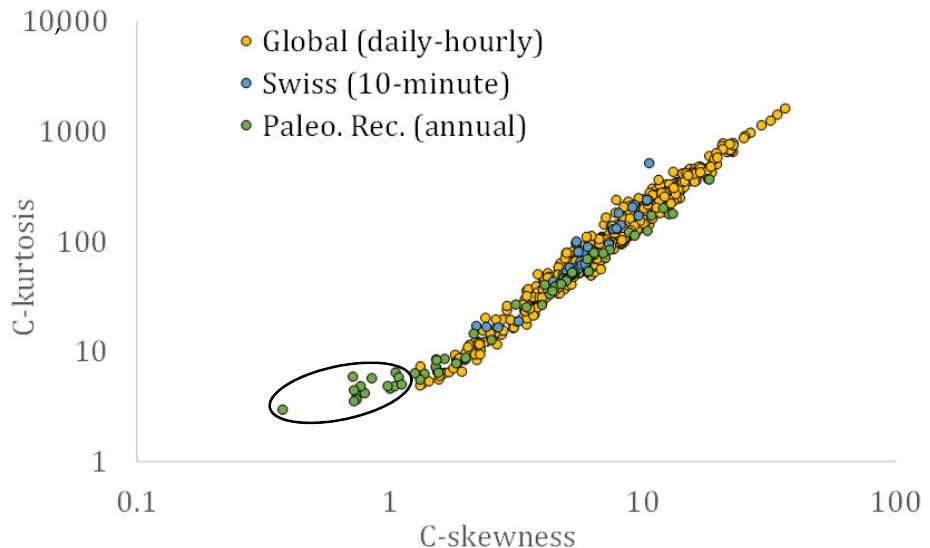
Figure 3. Skewness coefficient vs. kurtosis coefficient of the streamflow time series from the Dimitriadis et al. [6] analysis (daily and hourly time series, denoted as Global ), for the Swiss dataset (10 min resolution, denoted as Swiss ) and for the paleoclimatic reconstructions (annual time series, denoted as Paleo. Rec. ).